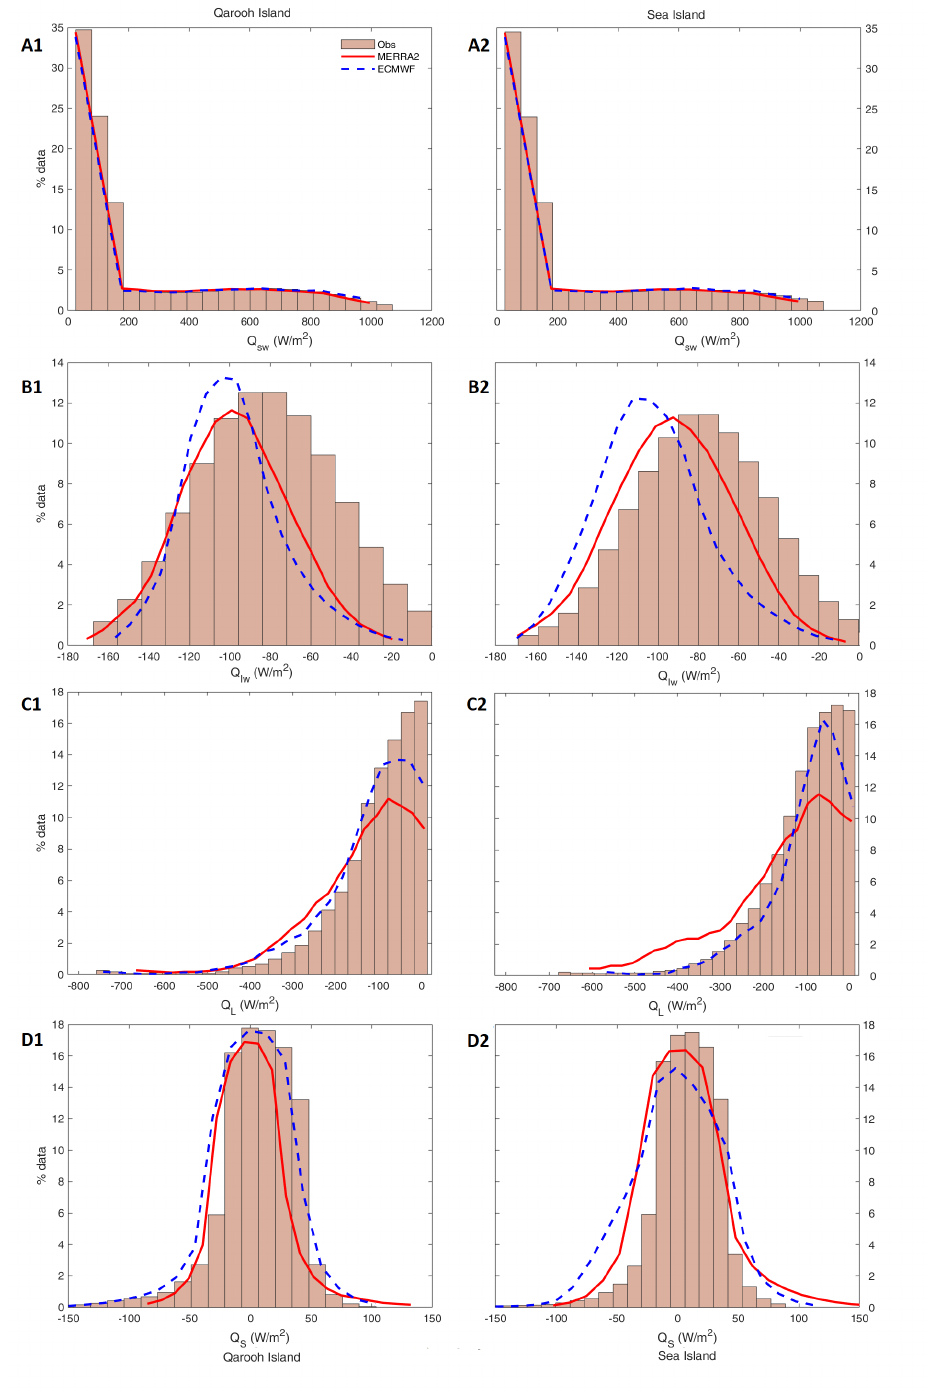
Figure 13. Surface air–sea fluxes histograms for the northern Gulf derived from hourly-average in situ observations (bars) and reanalysis products (NASA-MERRA2 and ECMWF-ERA5, solid red and dashed blue lines, respectively): ( A ) net shortwave radiation ( Q sw ) for Qarooh Island ( A1 ) and Sea Island ( A2 ); ( B ) net longwave radiation ( Q LW ) for Qarooh Island ( B1 ) and Sea Island ( B2 ); ( C ) latent heat ( Q L ) for Qarooh Island ( C1 ) and Sea Island ( C2 ) and ( D ) sensible heat ( Q S ) for Qarooh Island ( D1 ) and Sea Island (D2 ). Histograms were computed using twenty bins, evenly spaced between the minimum and maximum values. Vertical axes indicate the percentage of 10,921 collocated tuples (in situ, MERRA2, ERA5) that fall in the respective bins. Negative values indicate sea heat